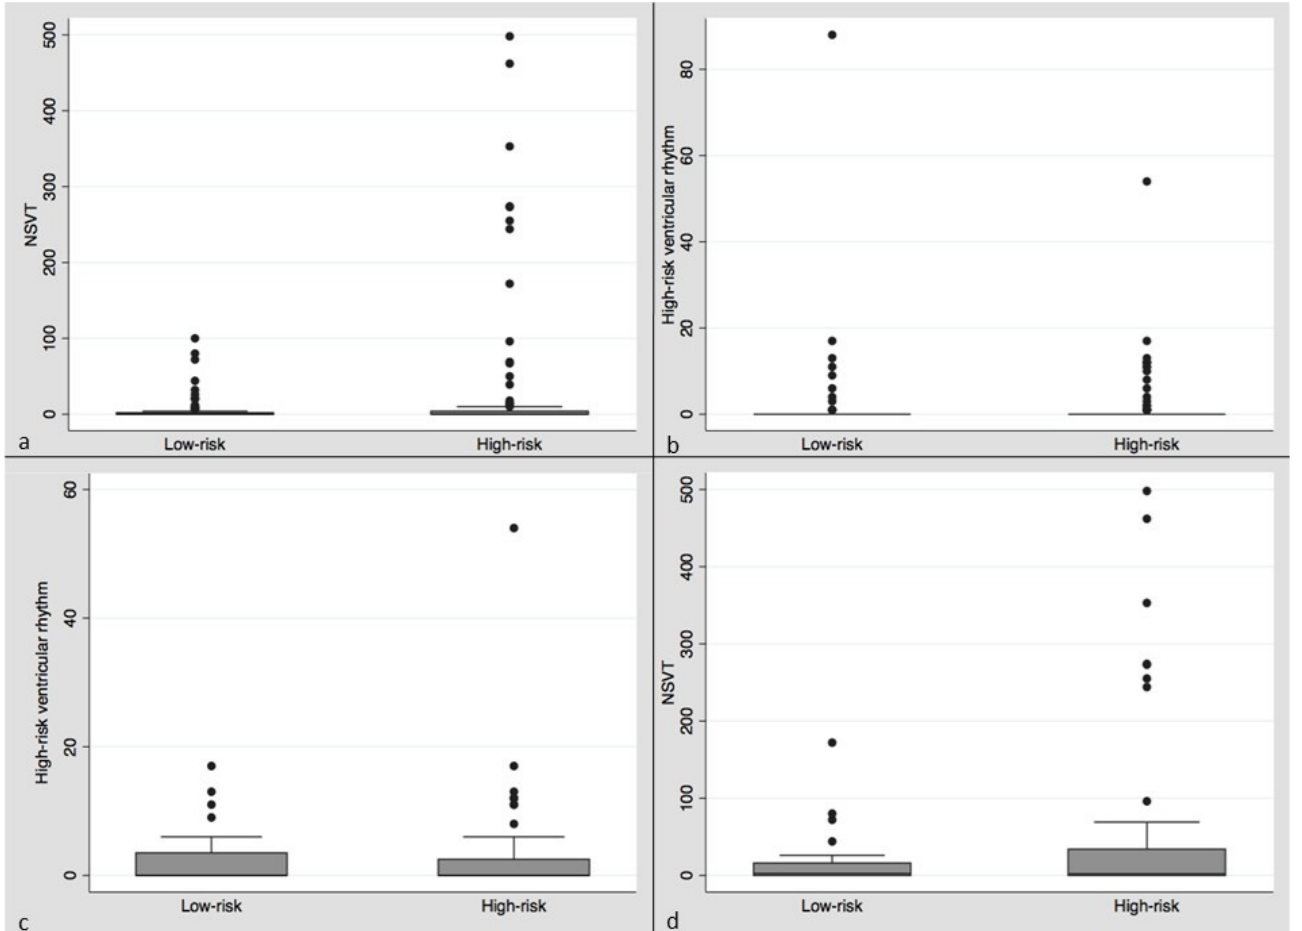
Figure 2. Box plots (mean, median, IQR) clockwise from upper left: ( a ) Box plot of NSVT episodes per patient in low versus high OSA risk categories over the follow-up period. ( b ) Box plot of high-risk ventricular rhythm episodes per patient in low versus high OSA risk categories over the follow-up period. ( c ) Box plot of NSVT episodes per patient in low versus high OSA risk categories in the AICD subgroup over the follow-up period. ( d ) Box plot of high-risk ventricular rhythms per patient in the low versus high OSA risk categories in the AICD subgroup over the follow-up period.